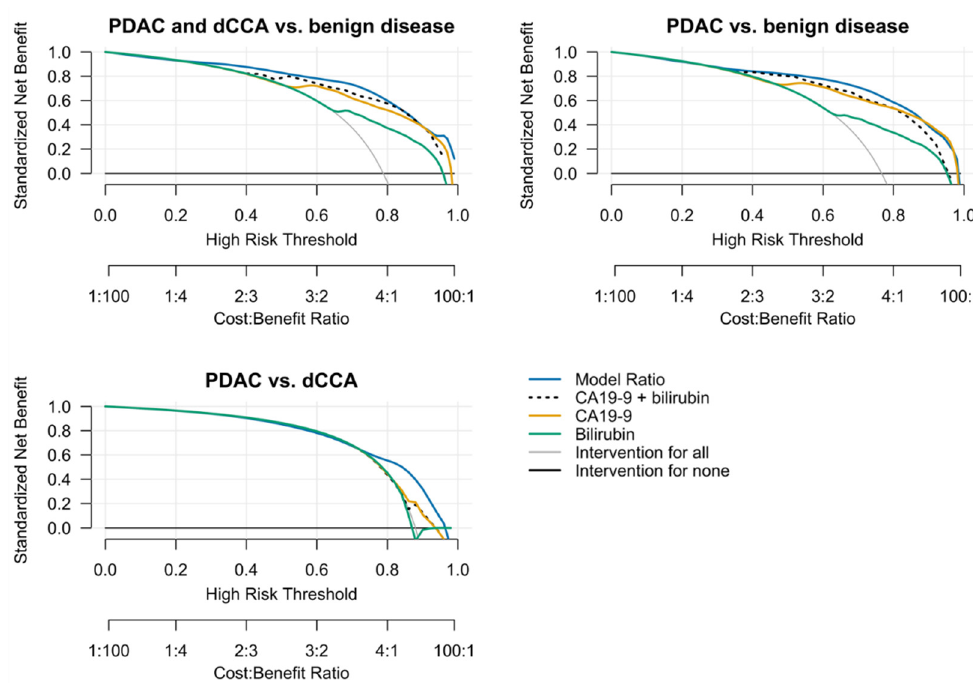
Figure 5. Overoptimism-corrected decision curve analysis using 1000 repeats of 5-fold cross-validation. Five-fold cross-validation was repeated 1000 times and results were averaged across all repetitions to obtain robust estimates of the stand- ardized net benefit at each threshold. Briefly, the clinical usefulness of a diagnostic test is assessed by compar-ing stand- ardized net benefit over a range of probability thresholds. Net benefit is defined as the number of true posi-tives found at a certain cut-off penalized by the number of false positives found for that cut-off, where the weight of the penalty is defined by the relative importance of finding a false positive. For further information regarding decision curve analysis, the reader is referred to [33, 34].